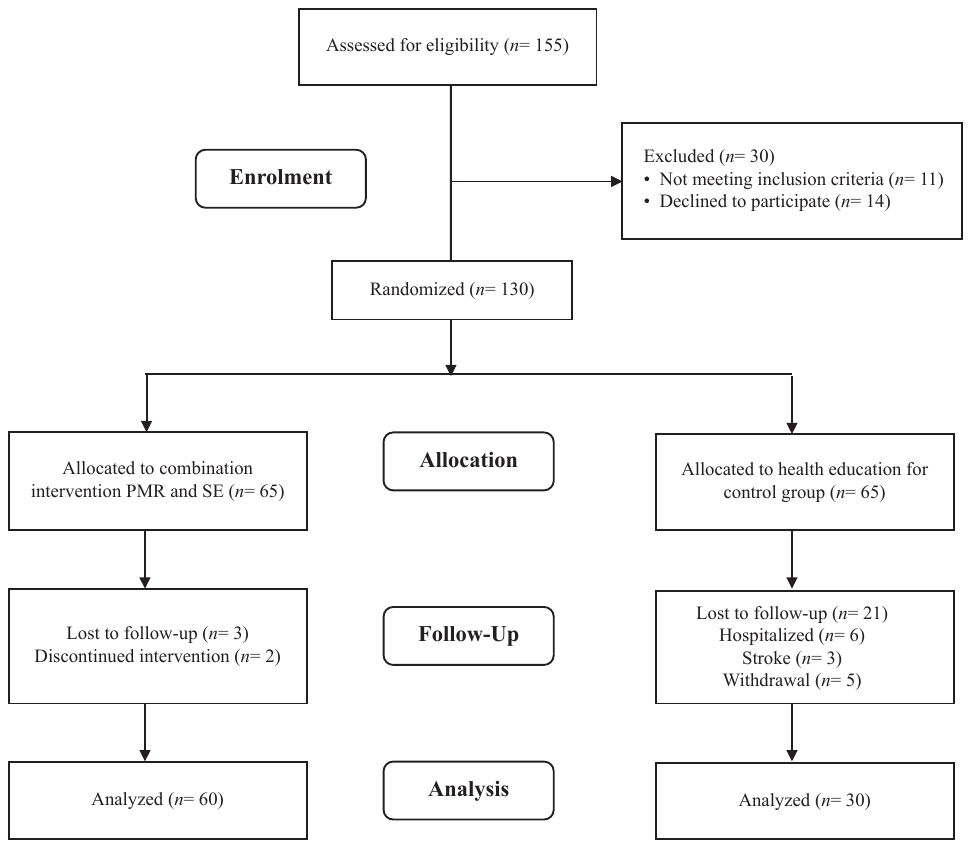
Figure 2. CONSORT Flow Diagram for enrollment, allocation, and follow-up study participant. PMR, progressive muscle relaxation; SE, stretching